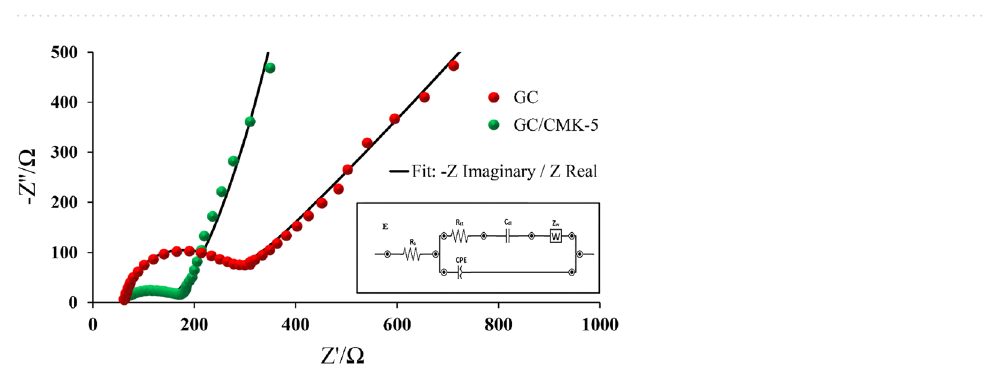
Figure 6. EIS characterization of GC and GC-CMK-5 electrode in 5.0 mM Fe(CN) 6−3/4 containing 0.1 M KCl with the frequency range of 0.1 Hz to 100 kHz at an amplitude of 10